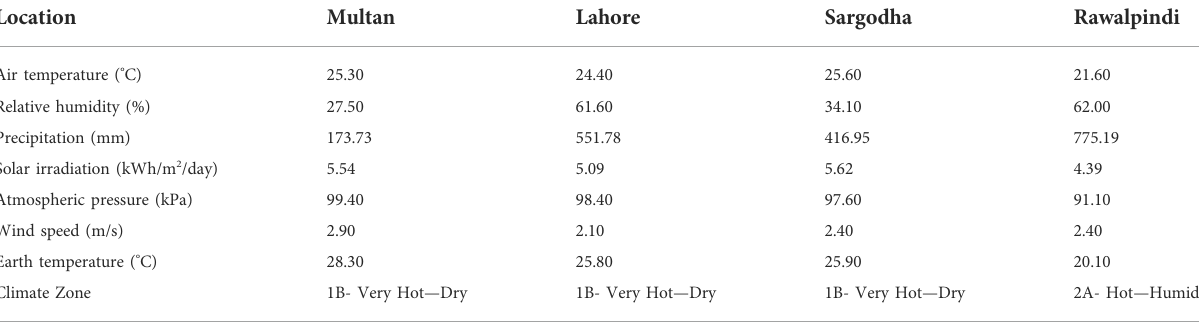
TABLE 3 Monthly average climate data of selected facility